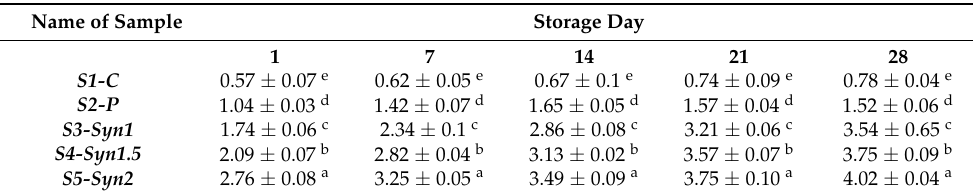
Table 3. Total phenol content of different yogurt samples in